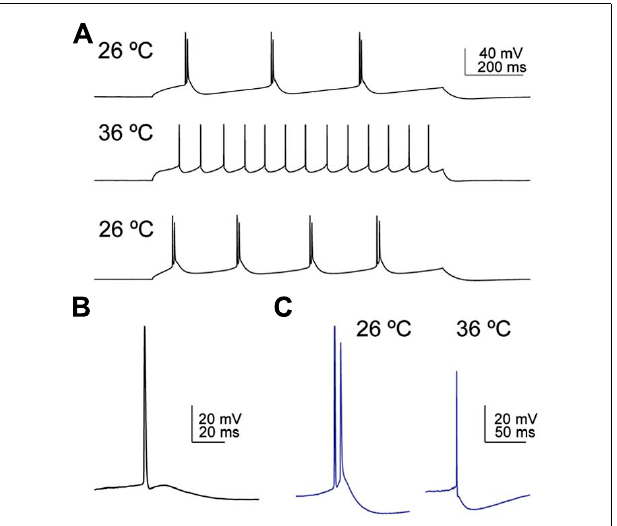
FIGURE 4 |Temperature influences the firing pattern and the depolarising afterpotential (DAP) following an action potential in corticofugal neurons. (A) CSp neuron labeled from the cervical spinal cord fired bursty episodes at 26 ◦ C, regularly at 36 ◦ C, and reversed back to bursty firing on decreasing the bath temperature back to 26 ◦ C. (B) Example of a typical DAP in a CSp neuron recorded at 26 ◦ C.The AP was triggered by slow ramp current injection. (C) Example of a CTh neuron that fired a spike doublet at 26 ◦ C and a single AP at 36 ◦ C.The spike doublet was triggered from the DAP following the initial AP at 26 ◦ C and only a small DAP was apparent at 36 ◦ C. On prolonged current injection the same neuron fired bursty episodes only at 26 ◦ C, and in a regular pattern at 36 ◦